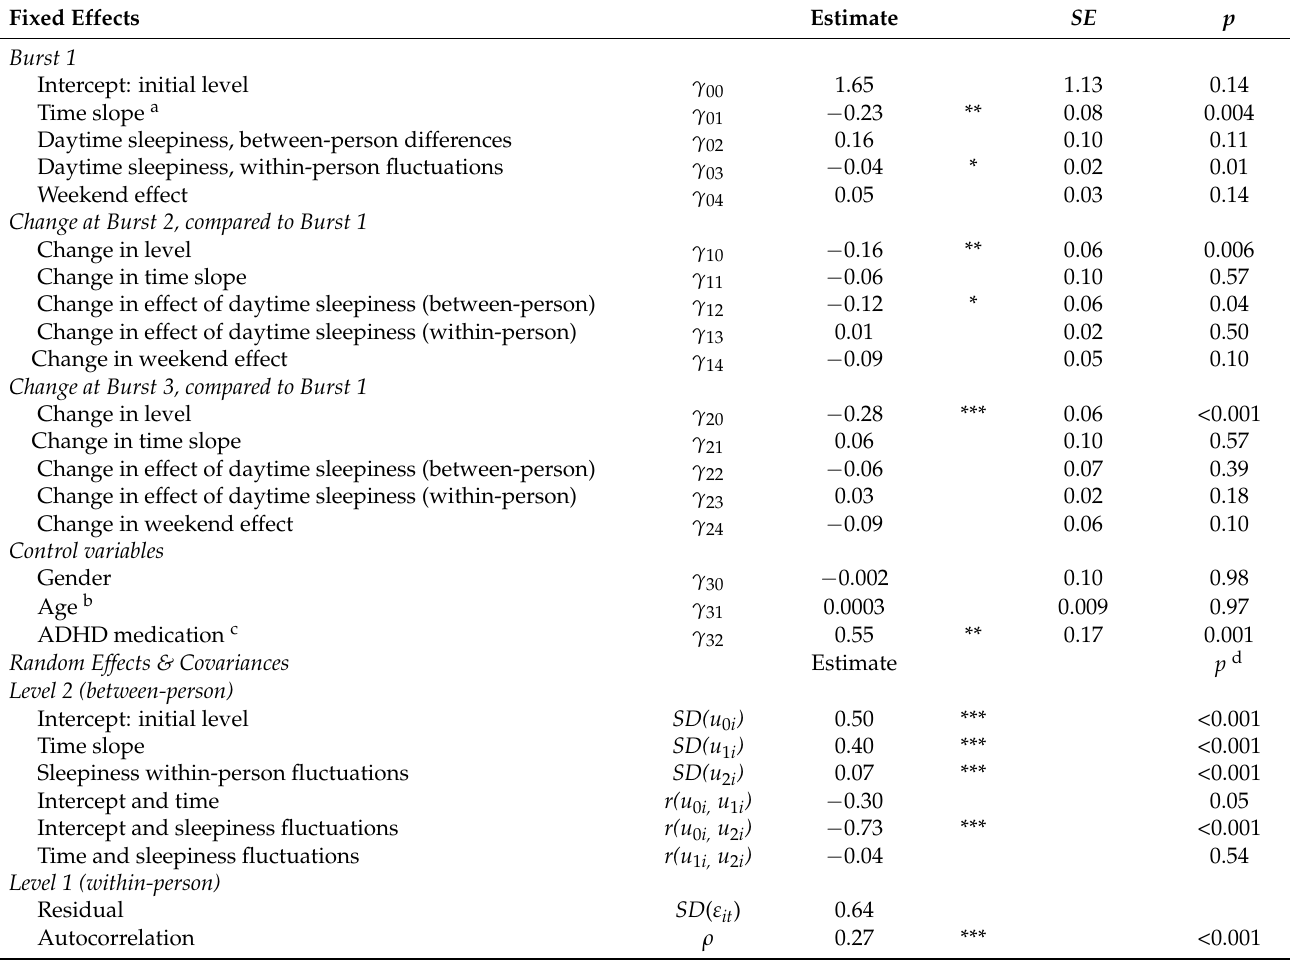
Table 3. Multilevel model to test the between- and within-person association between children’s daytime sleepiness and concurrent ADHD symptom